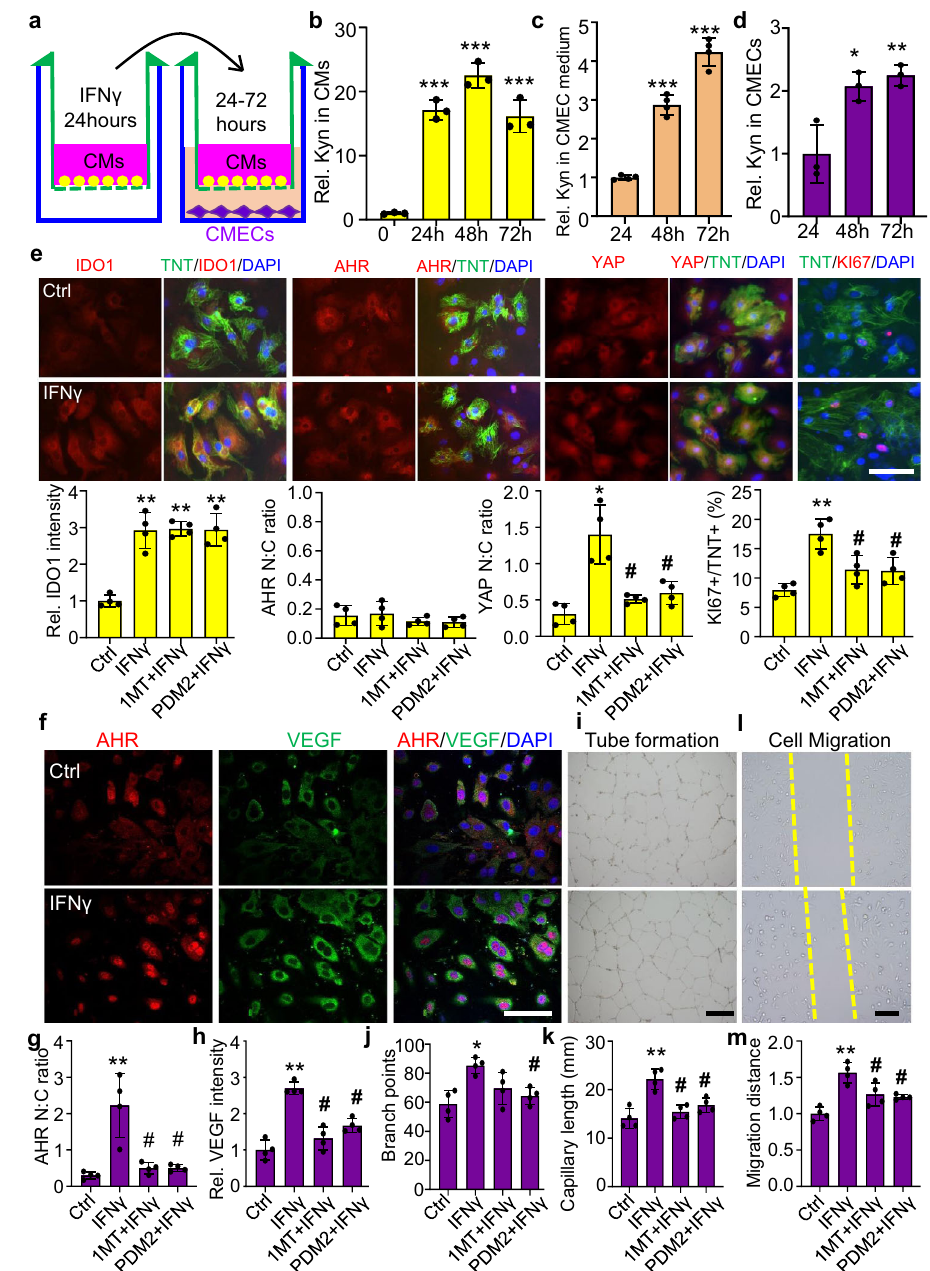
Fig. 6 | Kyn promotes CM proliferation and cardiac microvascular endothelial cell (CMEC) angiogenesis in vitro on co-culture of CMs and CMECs. a The experimental procedure for co-culturing primary CMs and CMECs. b – d Kyn con- centrations in CMs, CMEC medium, and CMECs detected by HPLC. Relative (Rel.) Kyn concentrations was set as 1 at 0-h group in b ( n =3/group. *** P <0.001 com- paredto0-hgroupbyone-wayANOVAfollowedbyTukey ’ smultiplecomparisons), and at 24h group in c , d ( n =4/group in c ; n =3/group in d ). * P <0.05, ** P <0.01, *** P <0.001 compared to 24-h group by one-way ANOVA followed by Tukey ’ s multiplecomparisons. e Co-immunostainingandquanti fi cationofthelocationand